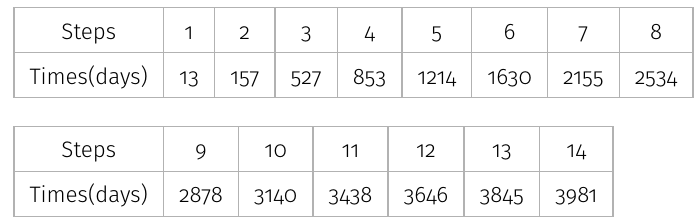
Table IV. Chosen time steps for calculating the geotechnical